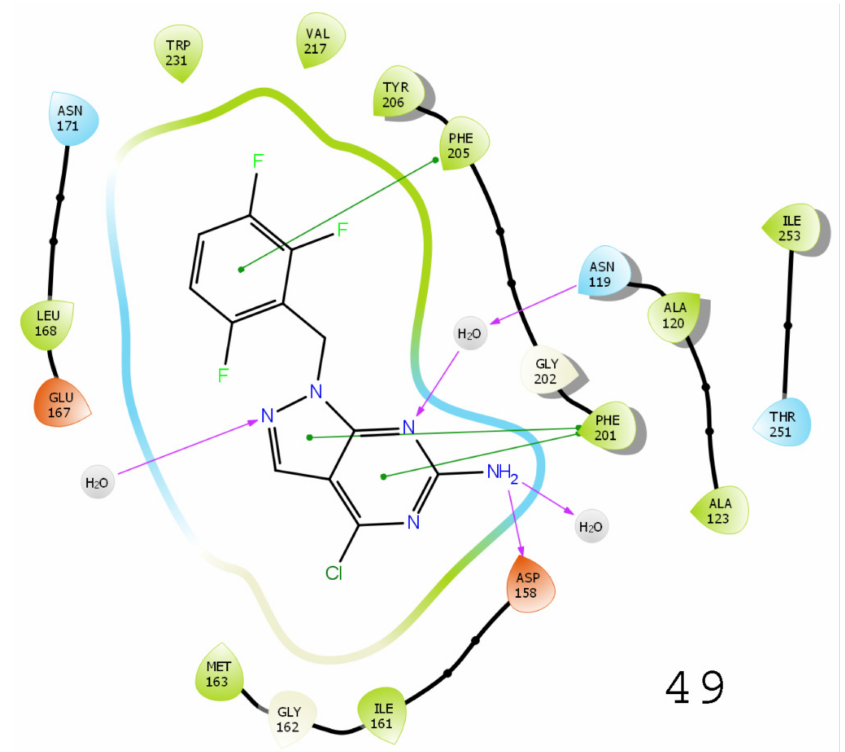
Figure 7. A 3D and a 2D diagram show binding interactions of compounds 42 and 49 with TRAP1 (PDB ID: 5Y3N).